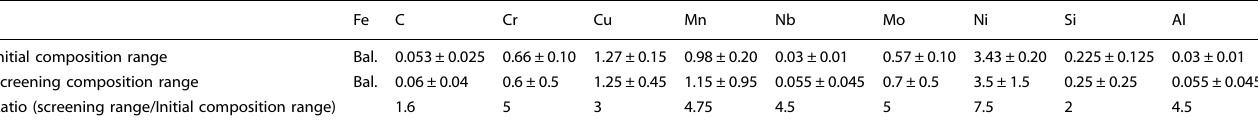
Table 1. The initial composition range (wt%), screening range (wt%), and their ratio for different elements in the manufactured AM powder for HSLA-115 steel. Fe